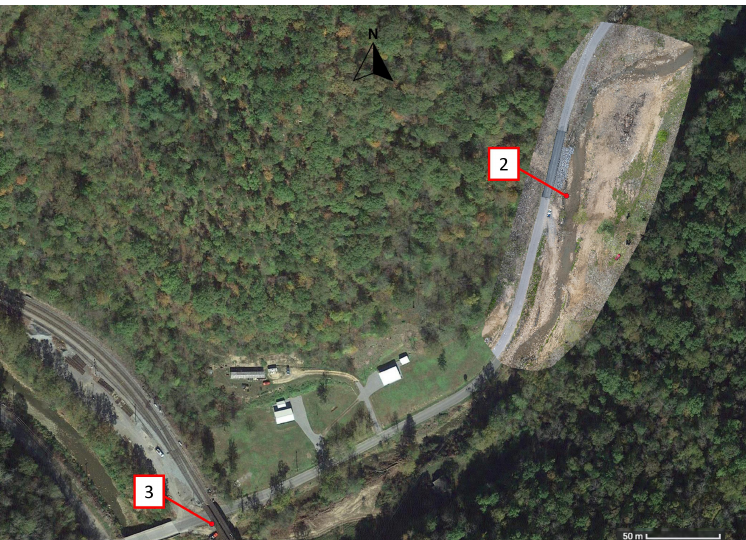
Figure 11. The second and third flood depth measurement locations marked on an orthophoto overlaid on satellite imagery. The second measurement, labeled ’2’, was taken along the stream, next to the road. The third measurement, labeled ’3’, was taken at the railroad bridge at the end of the